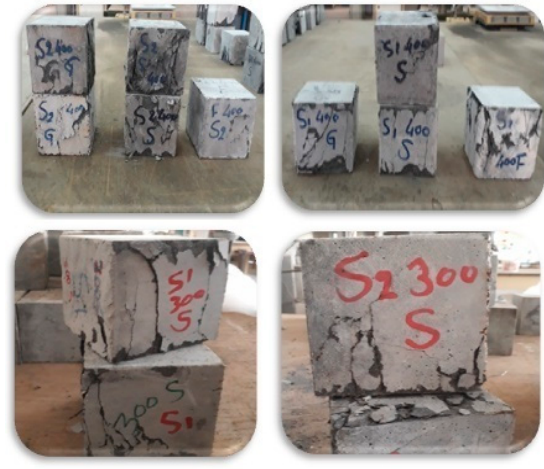
Figure 3. RPC samples at different burning temperatures and steel fiber volume fraction percentage after compressive strength test.